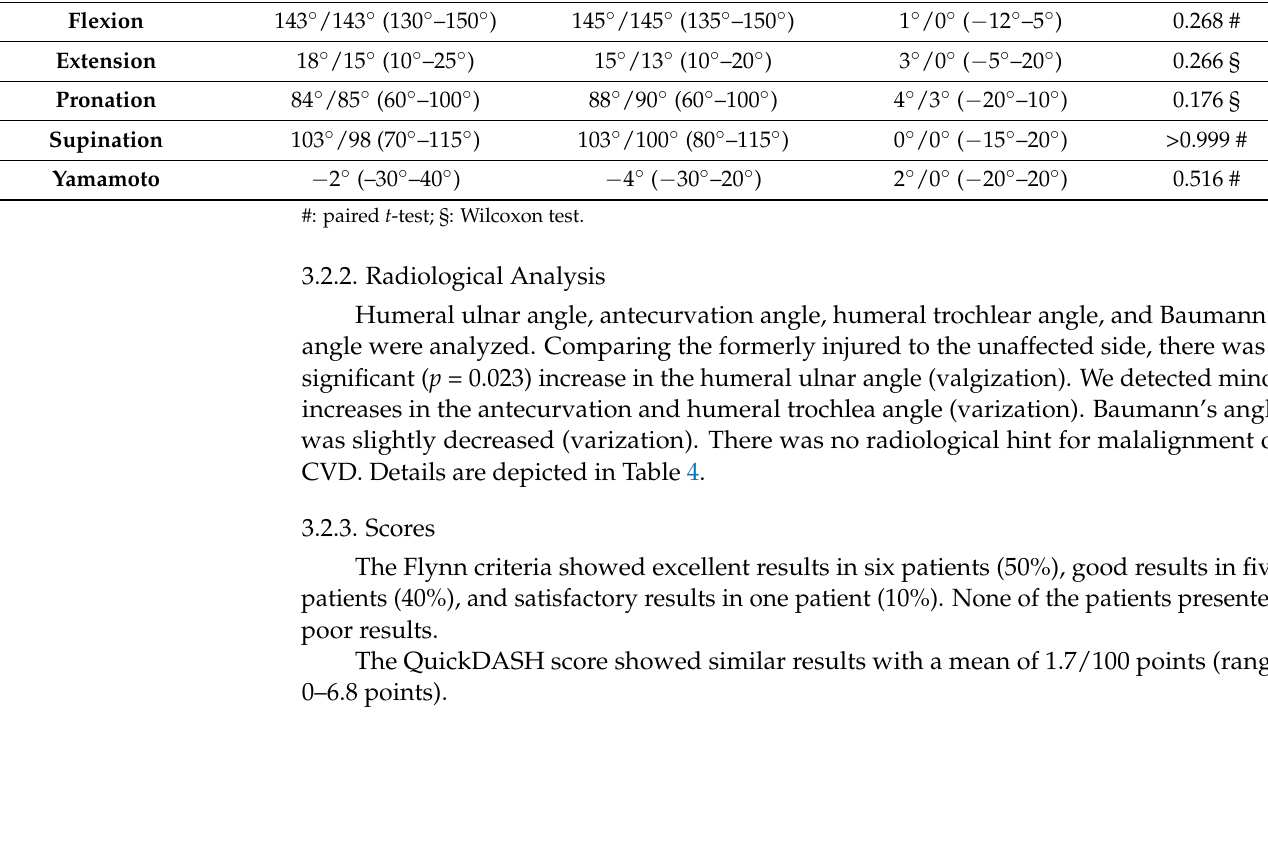
Table 3. TheassessmentoftherangeofmotionandYamamotoangleasmeasurementsforinternalrotation. Injured